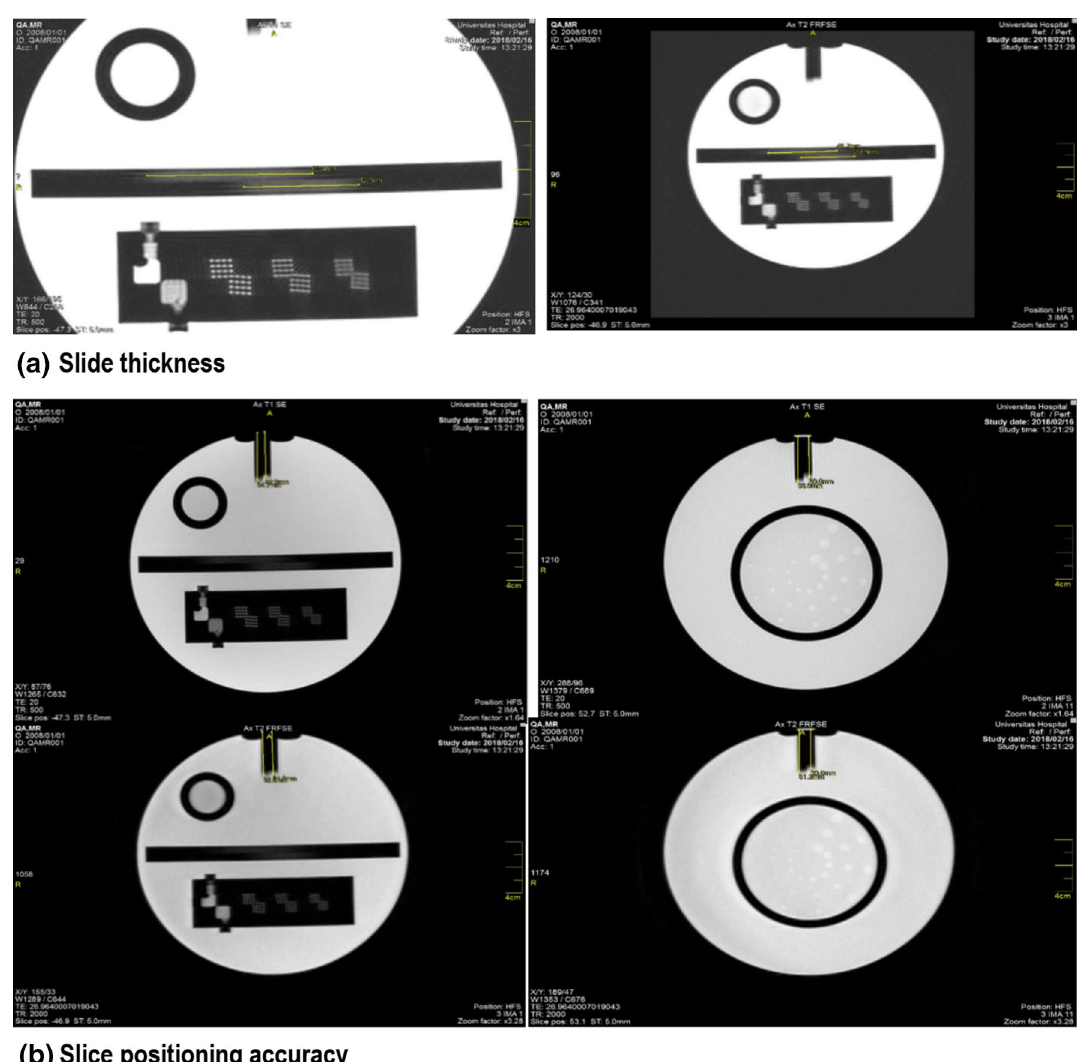
Fig. 4 a Slide thickness; and b Slice positioning